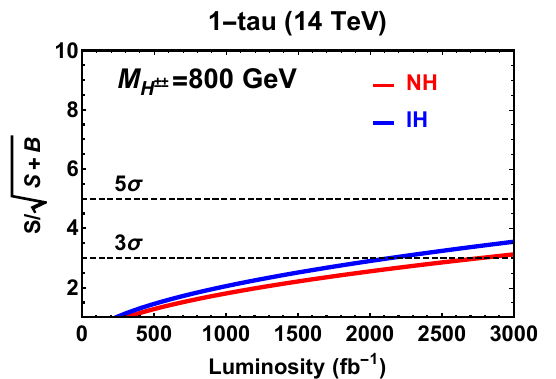
( (cid:0) ) (cid:23) (cid:28) versus integrated = 800 H (cid:6)(cid:6)